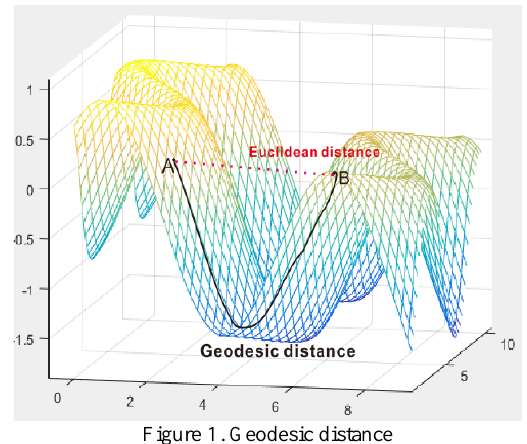
Figure 1. Geodesic distance